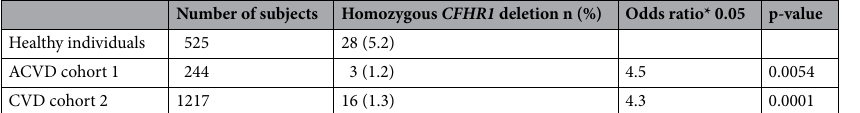
Table 2. Homozygous CFHR1 deficiency in patients and healthy individuals. CVD coronary vascular disease, ACVD atherosclerotic coronary vascular disease. *Fold increased risk in non- CFHR1 -deficient individuals. Chi-square test, Fisher’s exact